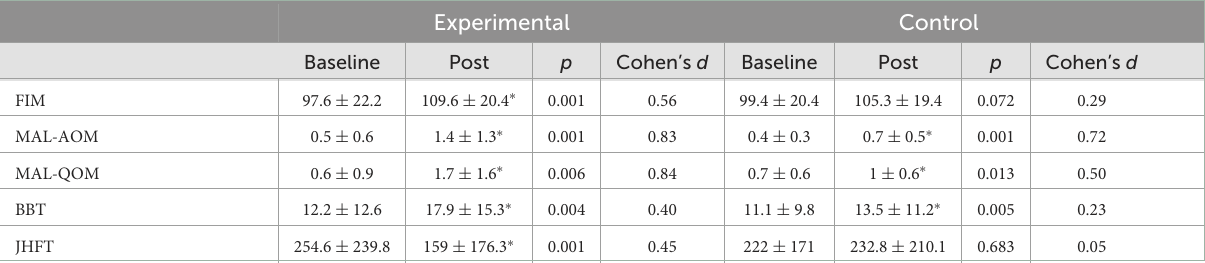
TABLE 2 Result of the primary outcome performance in activities of daily living and participation assessed by the functional independence measure, motor activity log, box and blocks test, and Jebsen hand functional test. Experimental